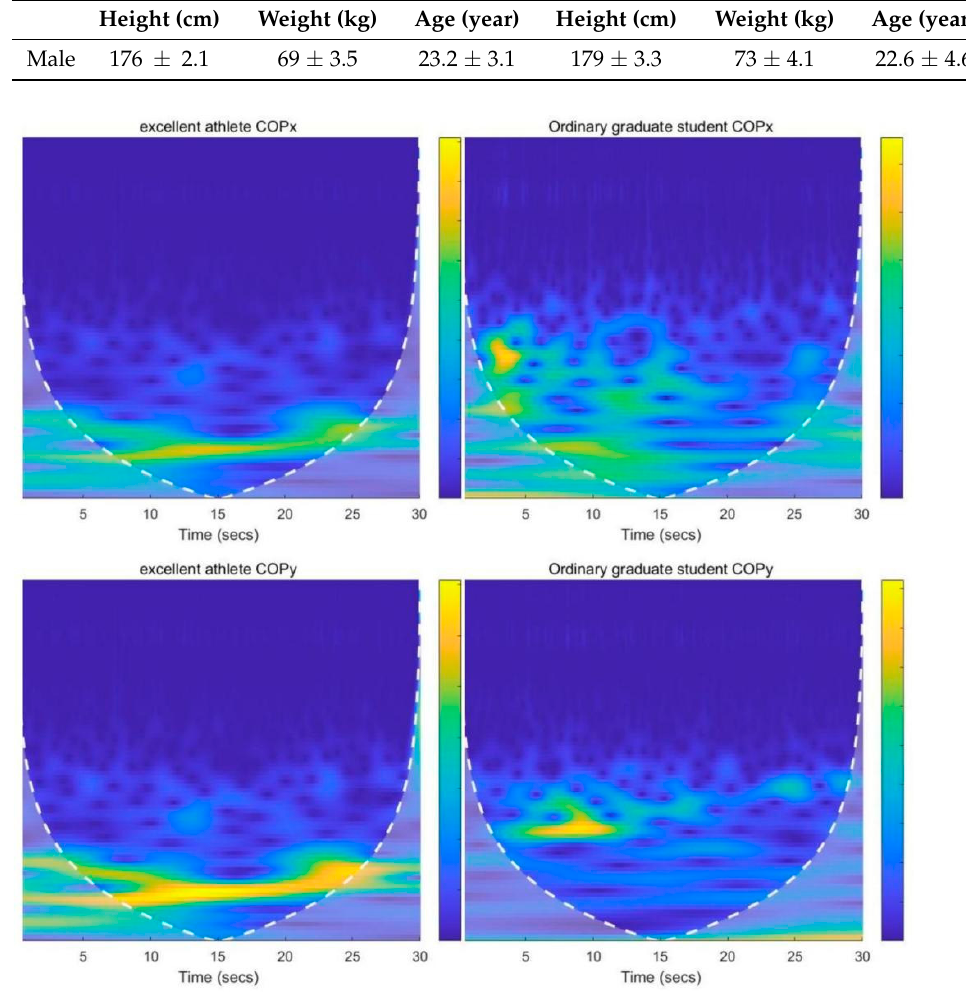
Figure 1. WT Multi-scale Spectra Diagram of COP for Different Subjects .